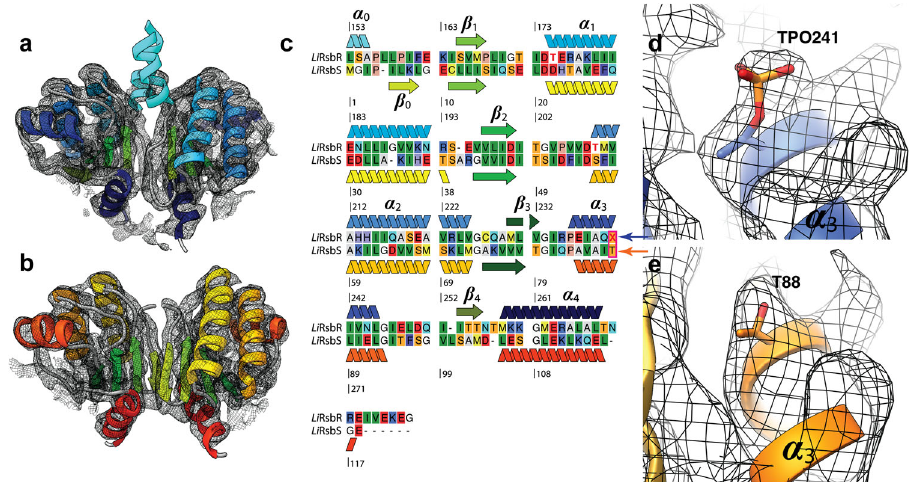
Fig. 2 Model of the STAS-domains in the stressosome complex from L. innocua . a Li RsbR and b Li RsbS. The helices of Li RsbR, ɑ 0 – ɑ 4 are shown in different shades of blue and the β -sheets, β 0 – β 4 in shades of green, respectively. In Li RsbS the helices are color-coded in yellow/orange and β -sheets in shades of green. The D2 cryo-EM map is shown as black mesh. The density of ɑ 0 was very pronounced and allowed for an unambiguous assignment of the STAS core with the stoichiometry of 20 Li RsbR 2 : 10 Li RsbS 2 described in Fig. 1. c The topology of ( a , b ) is shown in the sequence alignment of Li RsbR and Li RsbS and Supplementary movie 3. X indicates the phosphorylated threonine residues. The density map and model of the region of ɑ 3 containing the conserved threonine adjacent to the phosphorylation site ( d ) in a phosphorylated state in RsbR ( e ) in an unphosphorylated state in RsbS.